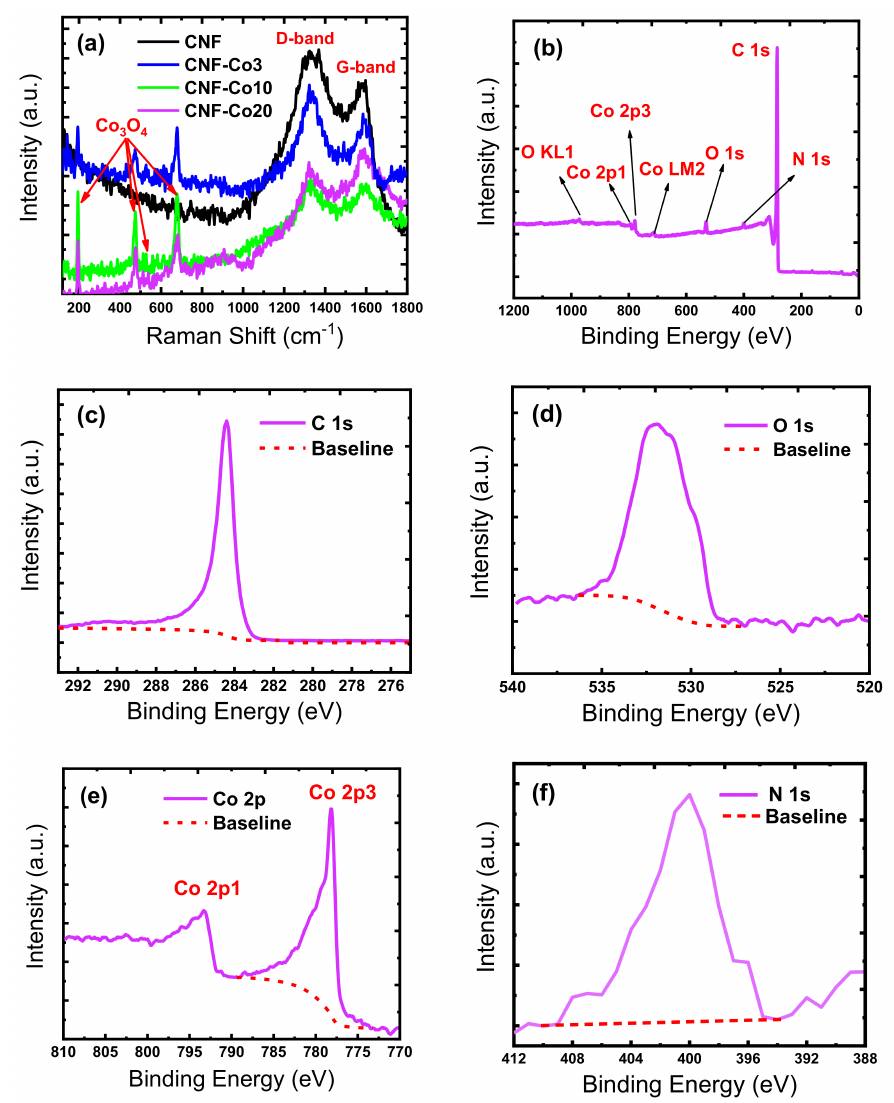
Figure 4. ( a ) Raman spectroscopy and XPS spectra of the prepared CNF-Co10 electrodes: ( b ) survey scan; ( c ) C 1 s; ( d ) O 1 s; ( e ) Co 2p; ( f )